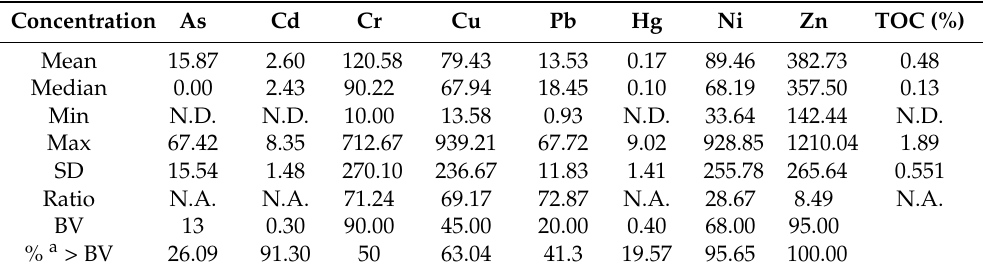
Table 1. Descriptive statistics for analytical results of heavy metal contents (mg/kg) and total organic carbon (%) in sediments collected from 46 sampling sites ( n = 138).